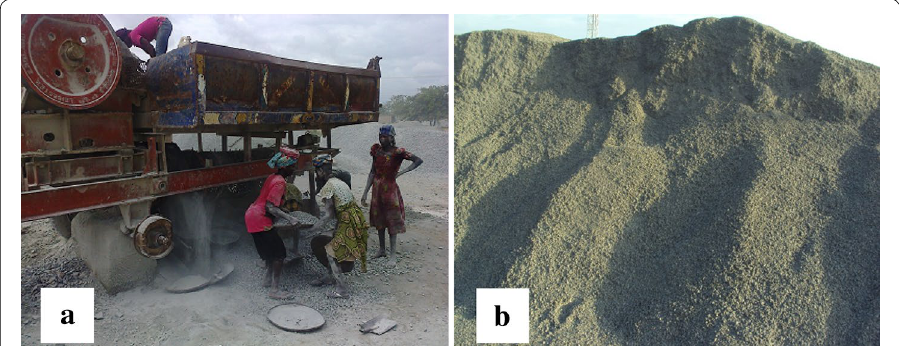
Fig. 1 Photographs of shale quarry dust at Umuoghara industrial sites. a Shale being processed into aggre- gates with its dust. b Part of shale quarry dust used for the